Question: Which kind of chart has been used to present this data?
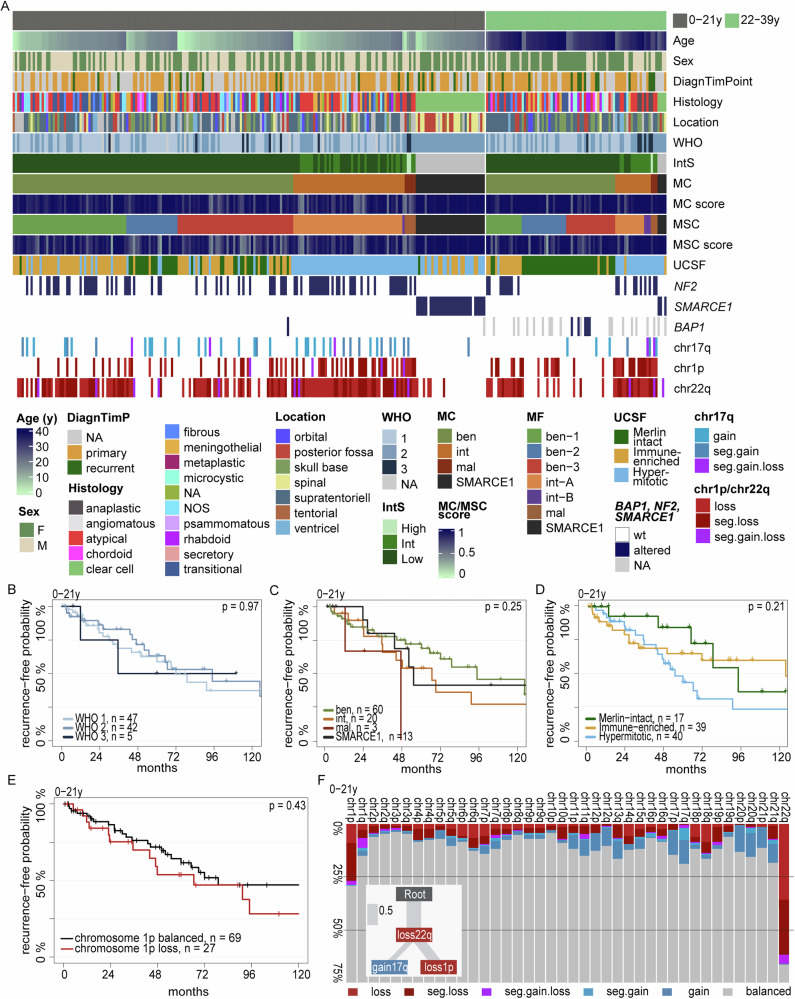
Answer: survival